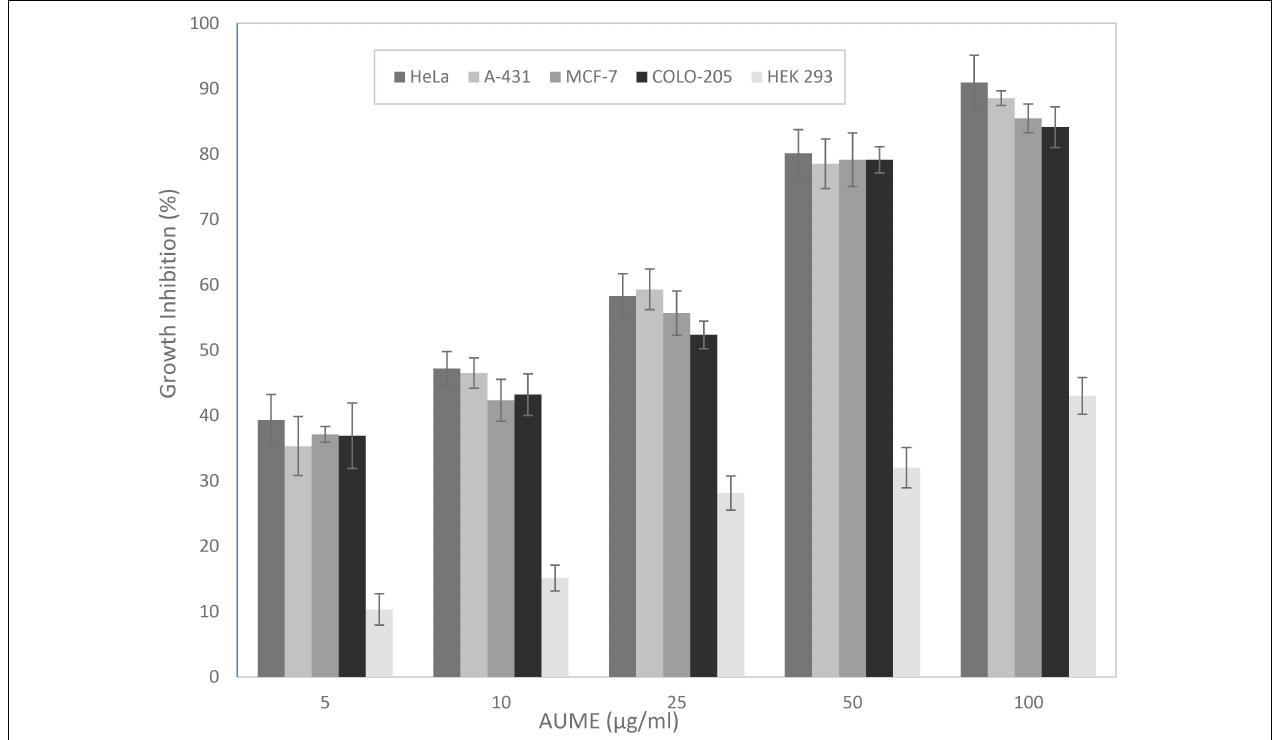
FIGURE 2 | Antiproliferative activity of A. unguis AG 1.1 (G) mycelial extract (AUME) on different cell lines estimated using MTT assay, expressed in percentage growth inhibition. The data shown are average ± SD of values obtained from three replicates, p < 0.05.